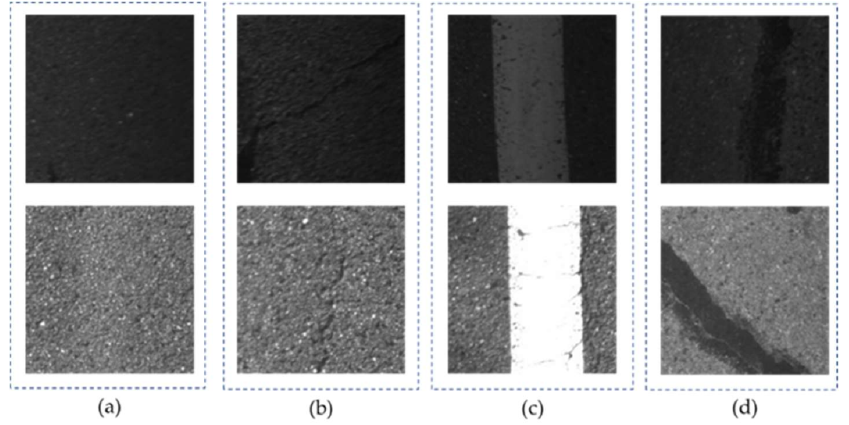
Figure 2. Example images from the JAPs dataset used in this study: ( a ) background, ( b ) crack, ( c ) pavement marking, and ( d ) sealed crack.